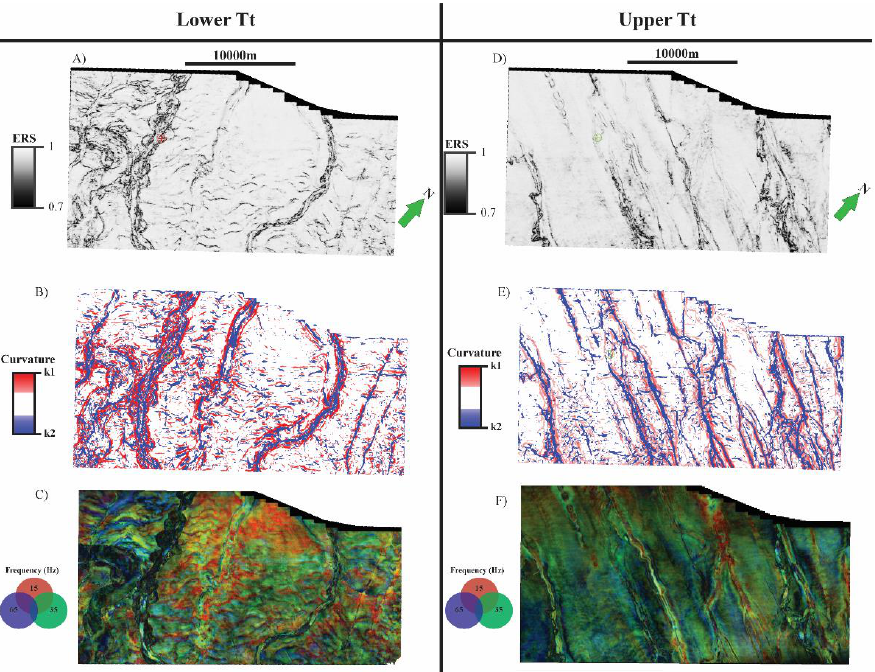
ponent. Abandoned meander belts are visualized by each attribute in the nearby channel to the northeast (Figure 9A,B). Arcuate-to-linear ERS anomalies are pervasive between the channel systems and are interpreted to be inter-channel sediment waves deposited by un- Figure 9. Attribute extractions along Lower Tt (lower Tt) and Upper Tt (late Tt) in the Hector-3D confined sediment flows [32]. A pair of linear gullies are present in the northeastern edge Figure 9. Attribute extractions along Lower Tt (lower Tt) and Upper Tt (late Tt) in the Hector-3D seismic survey. ( A ) Energy ratio similarity (ERS). ( B ) k1 and k2 curvature. ( C ) Red – green – blue of the survey and well-visualized by the curvature attribute (Figure 9A). Spectral decom- (RGB) blend of spectral decomposition frequency volumes. ( D ) ERS along Upper Tt. ( E ) k1 and k2 seismic survey. ( A ) Energy ratio similarity (ERS). ( B ) k1 and k2 curvature. ( C ) Red–green–blue position highlights two bright 3 km-long anomalies protruding from a meander loop (Fig- curvature. ( F ) Red – green – blue (RGB) blend of spectral decomposition frequency volumes. ure 9c). When viewed in cross-section, these correspond to a planar High Amplitude Re- (RGB) blend of spectral decomposition frequency volumes. ( D ) ERS along Upper Tt. ( E ) k1 and k2 flection Package (HARP) and are interpreted to be overbank splays (Figure 10A,B). The The channels are incised 150 ms TWT (approximately 170 m) and levee development curvature. ( F ) Red–green–blue (RGB) blend of spectral decomposition frequency volumes. channels to the northwest exhibit alternating bright responses from the 35 and 65 Hz fre- is not as prominent as in the Pipeline-3D area. Lateral migration of channel complexes is quencies respectively.